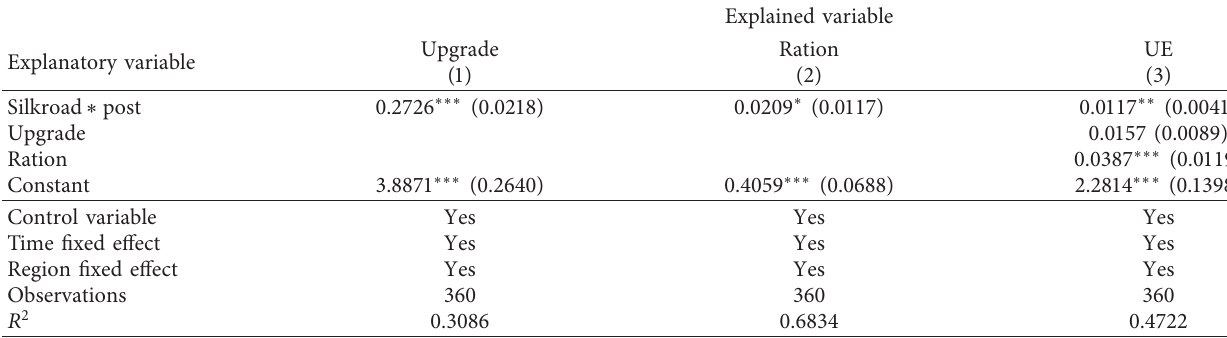
Table 9: Estimated results of multiple mediation models for robustness test.